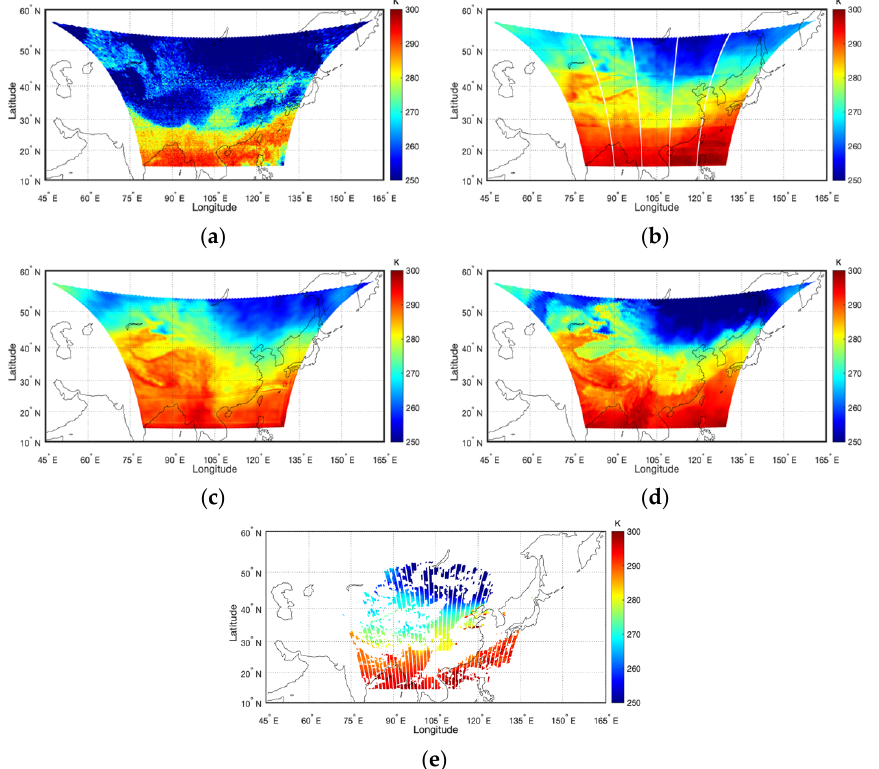
Figure 6. Temperature fields (unit: K) at 1000 hPa from 00 to 01 (UTC) on 01 February 2021: ( a ) 1D ‐